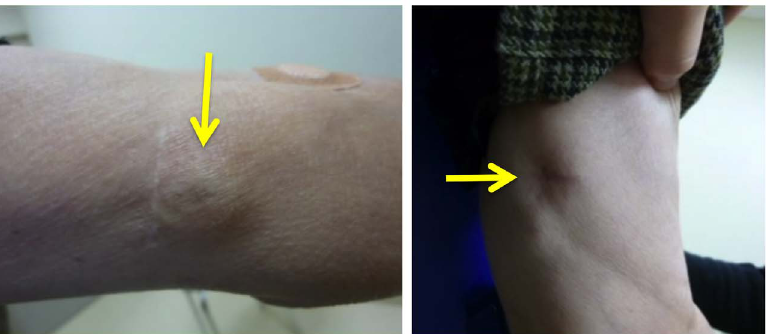
Figure 1. Appearance of the upper arms after CV port implantation. Arrows indicate implanted ports in the upper arm. It generally takes less effort to roll up a sleeve to provide access to the upper arm port than to completely remove a shirt for access to the subclavian port.